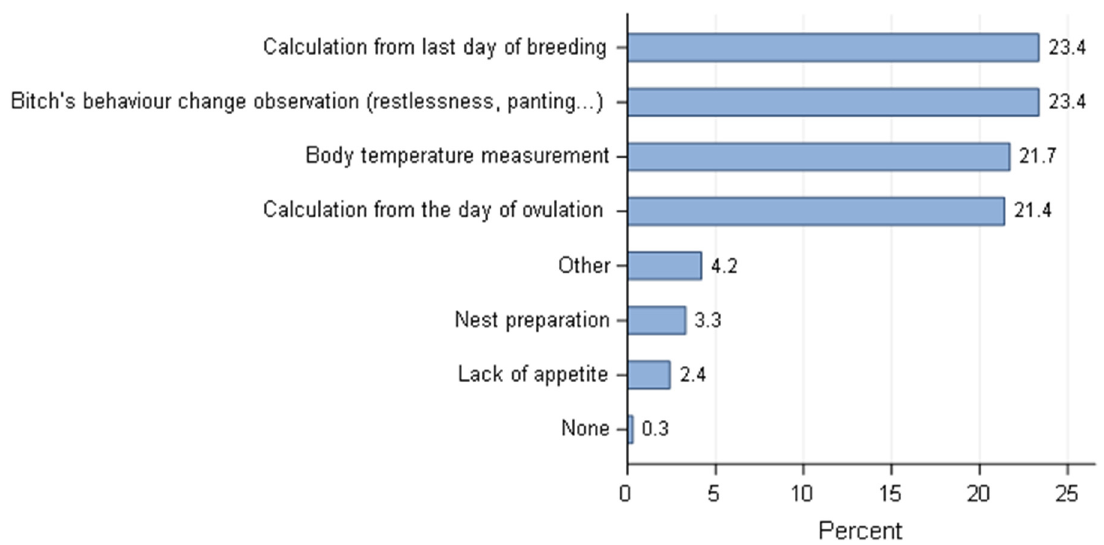
Figure 10. Overall distribution of methods to estimate the whelping time—all responders ( n = 668). Breeders in USA/Canada and Australia rely more on progesterone levels as an indi- cator of ovulation to calculate the whelping day, with a significant difference ( p = 0.0054) between USA/Canada and other countries as well as between responders from Australia and other countries. For European breeders, different methods were applied in a similar way (around 20%). In Brazil, the behaviour changes of the bitch around parturition was an important clue for breeders, as opposed to the USA/Canada where it is poorly